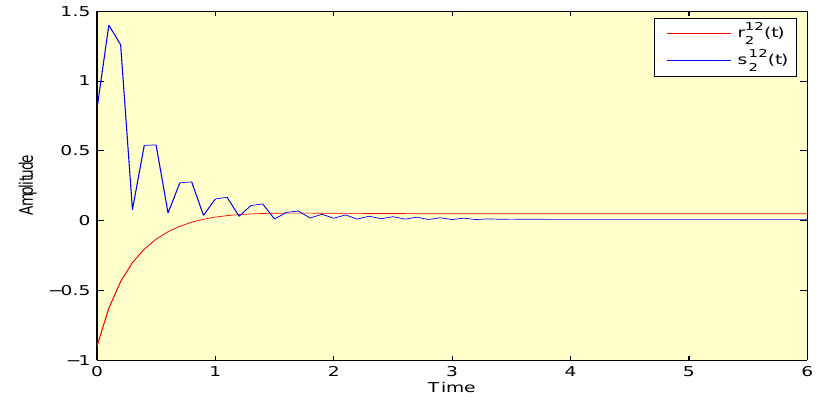
( t ) , (cid:115) 12 ( t ) of NN models (1) and (3). 2 2